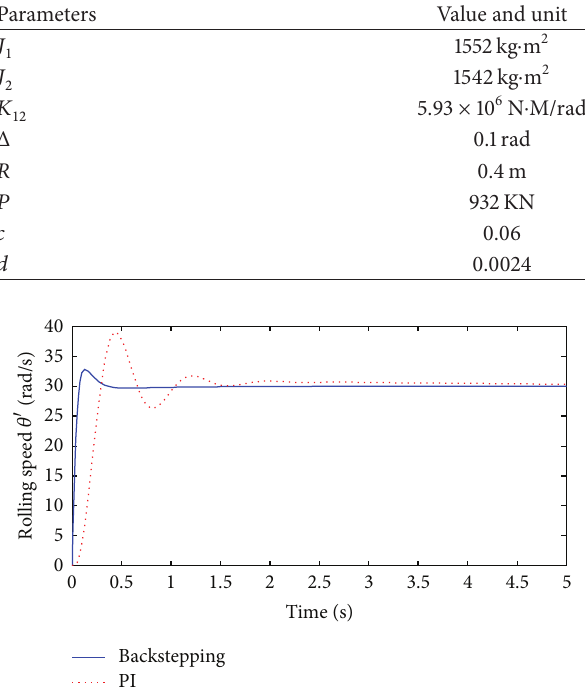
Figure 3: Step response of rolling speed within parameter uncer- tainties.